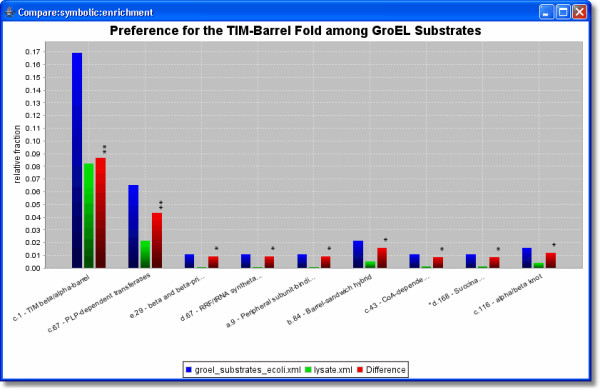
Example of a categorical comparison analysis. Frequency of SCOP folds in GroEL substrates compared with the whole E.coli lysate. Only folds that were found at least two times in both sets and that were significantly different at a significance level of 0.05 are shown. The stars on top of the red bars show that the differences are significant with the p-values: < 0.05 *, < 0.01 ** and < 0.001 ***. The figure is a screenshot of an interactive built-in visualisation module provided by PROMPT. All interactive plots allow easy adjustments (changing font sizes, title, axis labels, etc.) and can be saved as graphic files.